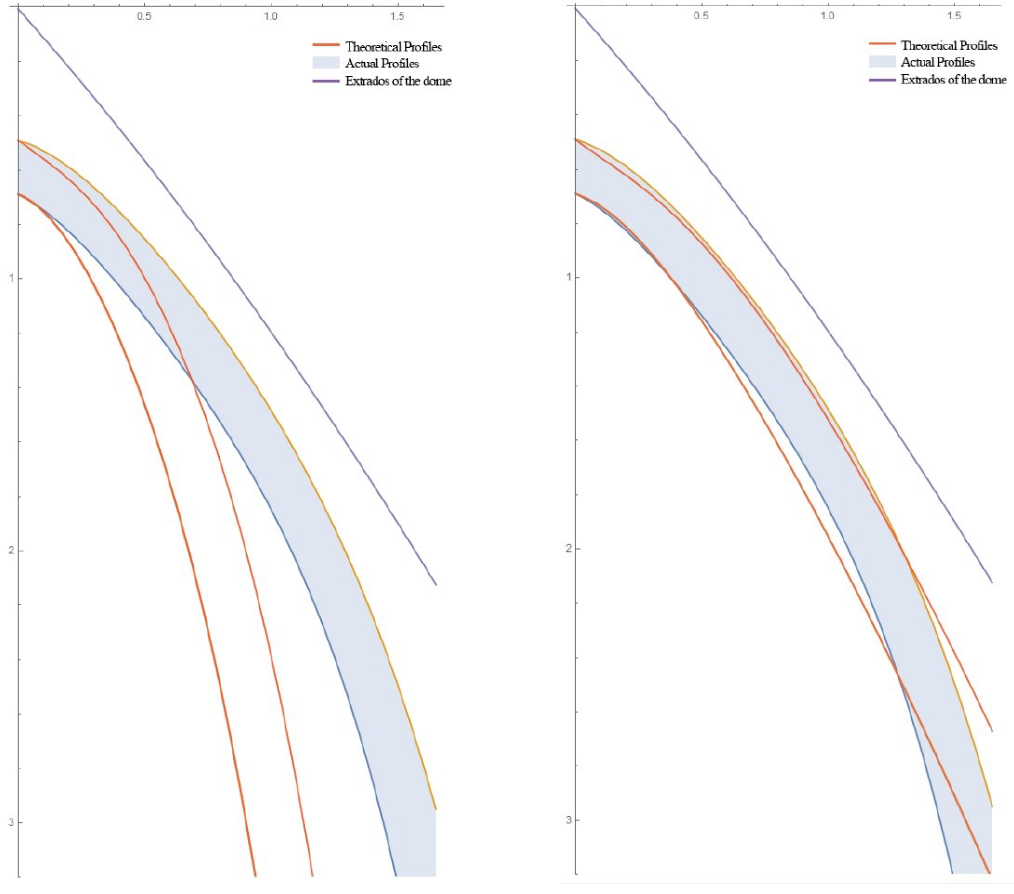
Figure 9: Comparison between actual and theoretical profiles of the candela considering the weight of the infill: (a) solution for the best-fit angle obtained for the only self-weight of the candela ( φ